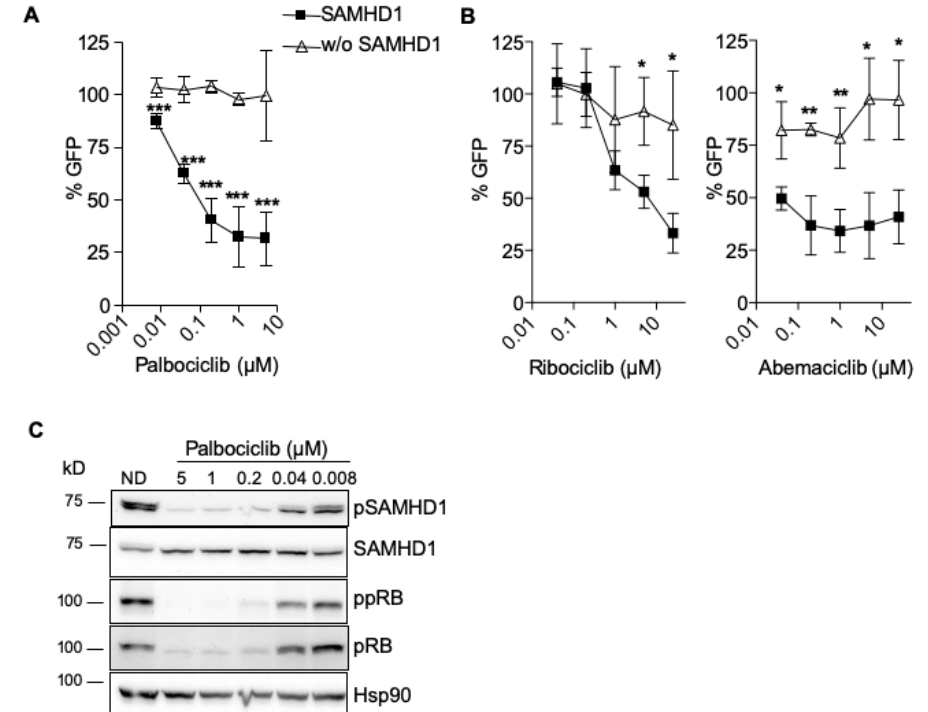
Figure 3. Antiviral efficacy of CDK4/6 inhibitors depends on SAMHD1 expression. ( A ) Dose response of the CDK4/6 inhibitor Palbociclib, in wild-type ( ■ ) or SAMHD1-depleted ( Δ ) MDM. Inhibition of HIV infection was measured as the percentage of GFP+ cells relative to the no drug condition. Mean ±SD of at least ten independent donors performed in duplicate is shown. ( B ) CDK4/6 inhibitors lose antiviral activity in SAMHD1-depleted macrophages. As in ( A ), dose response of two other CDK4/6 inhibitors, ribociclib (left panel) and abemaciclib (right panel), in wild-type ( ■ ) or SAMHD1-depleted ( Δ ) MDMs. Mean ±SD of two independent donors performed in duplicate is shown. ( C ) Palbociclib blocks SAMHD1 inactivation by phosphorylation. Western blot analysis of lysates of untreated MDMs (no drug, ND) or macrophages treated with palbociclib at the indicated doses. Membranes were blotted with an anti phospho-SAMHD1 antibody, total SAMHD1, anti phosho-pRB and total pRB. Hsp90 antibody was used as control. A representative donor is shown. * p < 0.05; ** p < 0.005; *** p < 0.0005.